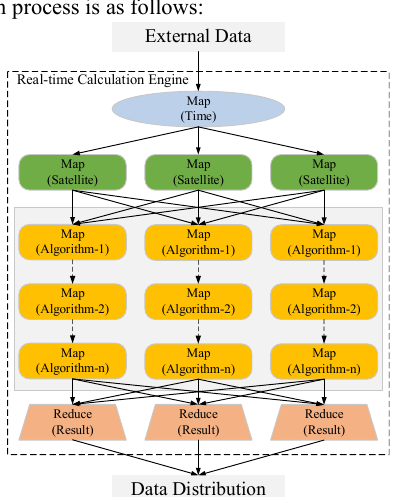
Figure 5. Processing flow of real-time